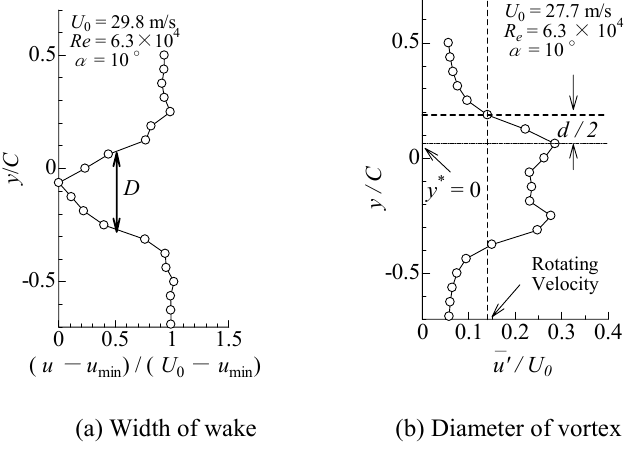
Fig.11 Analysis of the wake characteristics in the wake